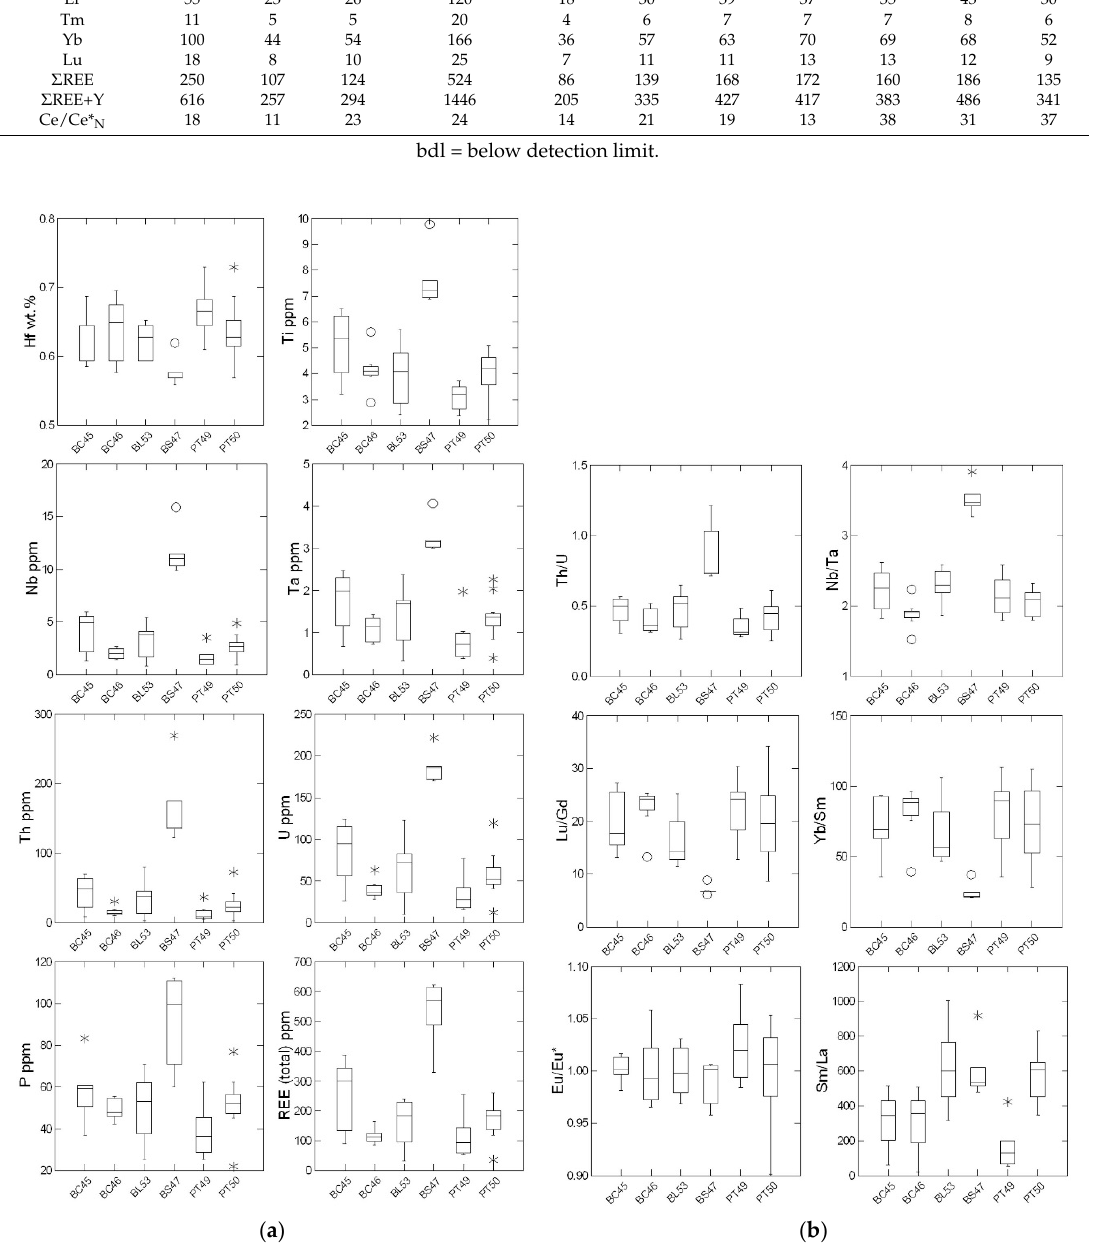
Figure 8. Boxplot diagrams for relevant trace element ( a ) and trace element ratios ( b ) in RVP zircon xenocrysts. The vertical line and whiskers represent the range in the data values with the horizontal line representing the median of the data set. The box is defined by the first and third quartiles.